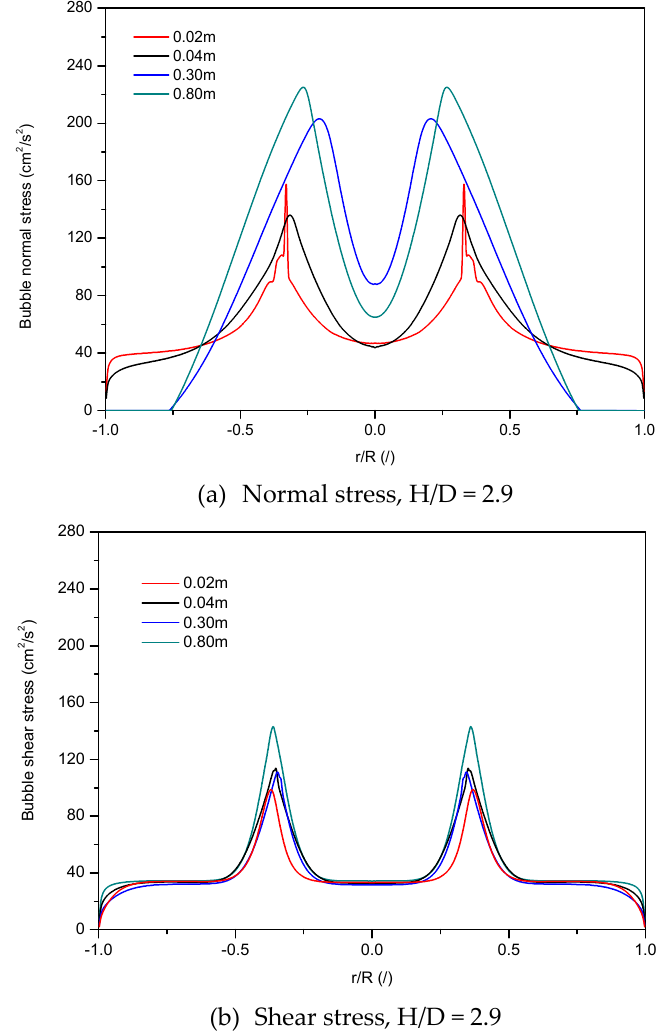
Figure 4. Distributions of bubble normal and shear stresses using two jetting holes (rjet/R = ±0.36), H/D = 2.9.